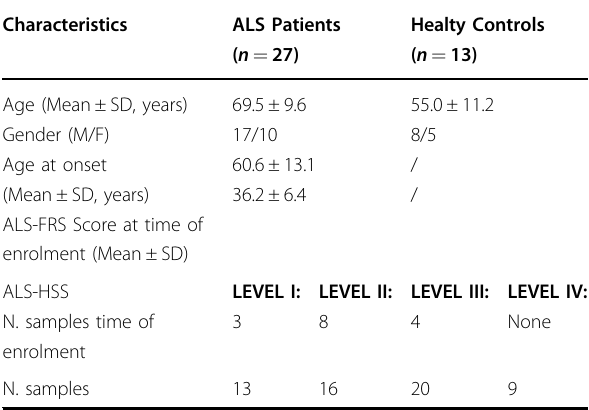
Table 1 Demographic and clinical data of patients and healthy controls included in the